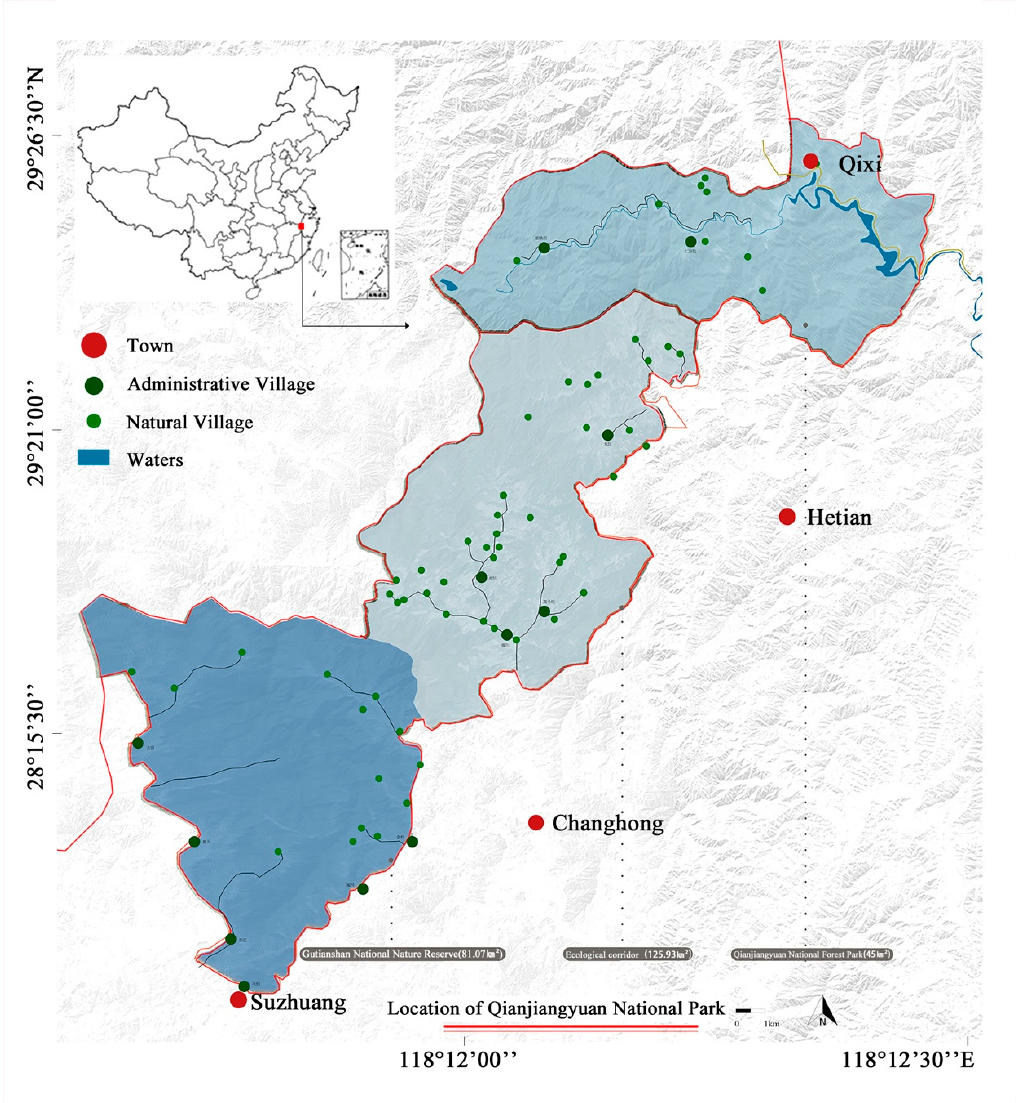
Figure 1. Location of Qianjiangyuan National Park.